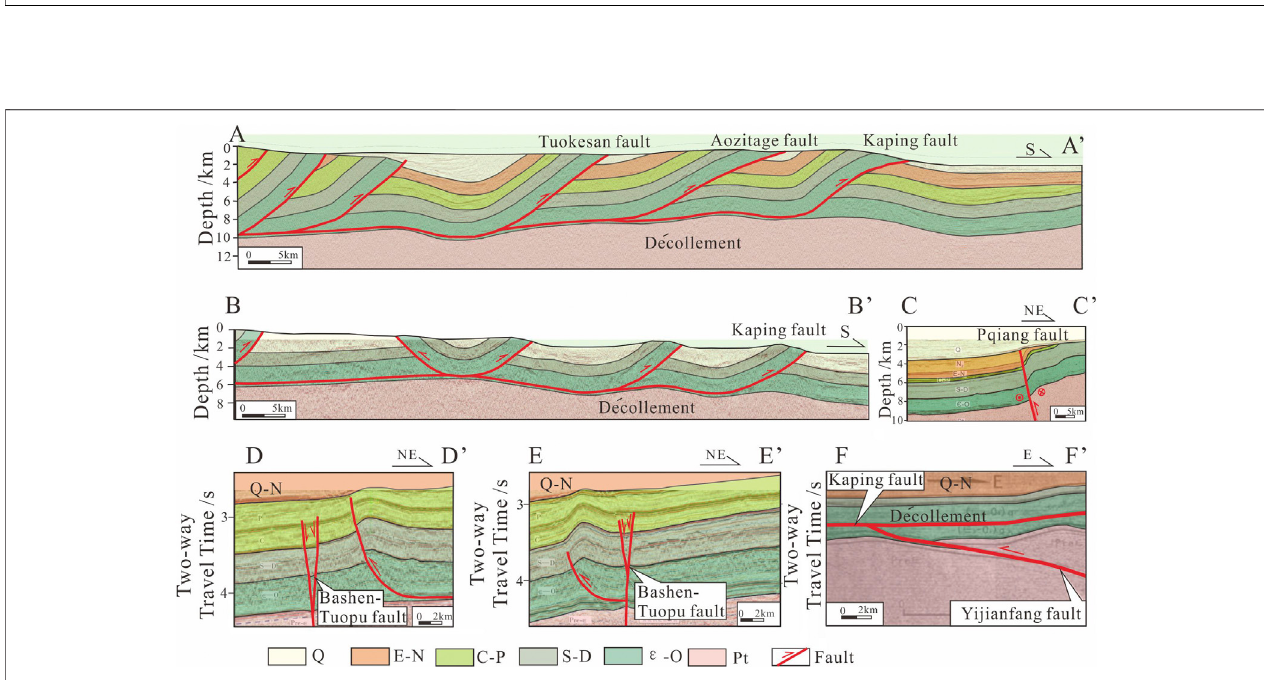
FIGURE2| InterpretationofthesyntheticseismicsectionsoftheJiashiregion(Xiaoetal.,2002;Lietal.,2019;Zhangetal.,2019;Yaoetal.,2019).Thelocationsof the sections and the acronyms for the names of the faults are shown in Figure 1 . Structural sections across and in front of the Kaping fold-and-thrust zone show the deformation architectures and décollement.